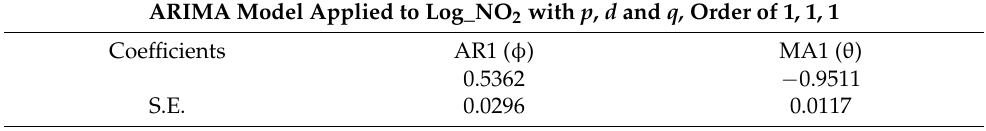
Table 4. Estimating the parameters of the ARIMA (1,1,1) model for the NO 2 concentrations ( µ g/m 3 ) training